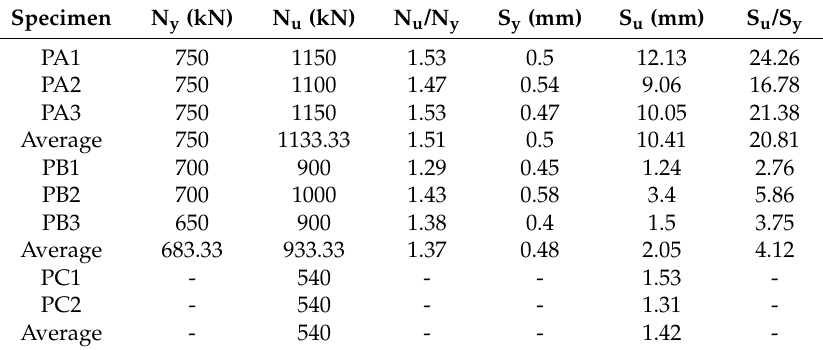
Figure 4. Load–slip curves of specimens. ( a ) PA specimens; ( b ) PB specimens; ( c ) PC specimens; ( d ) the comparison of PA2, PB2, and PC2. Table 2. Major experimental characteristics of pull-out specimens.